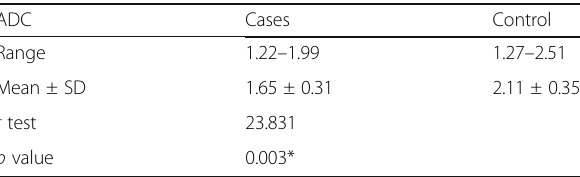
Table 5 Comparison between studied groups according to ADC value of optic chiasm ( n = 50) ADC Cases